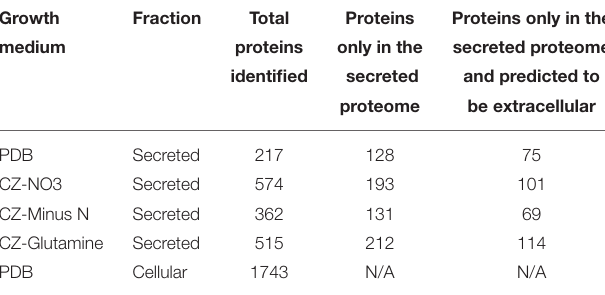
TABLE 4 | Proteins discovered in cellular and secreted